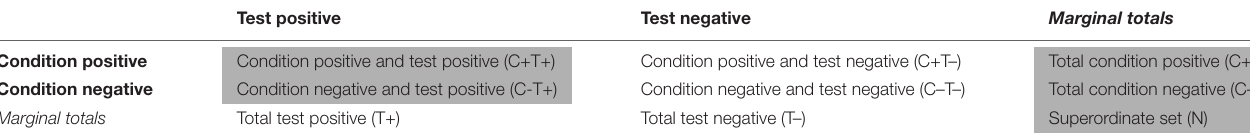
TABLE 1 | Bayesian reasoning task values organized in a 2 × 2 contingency